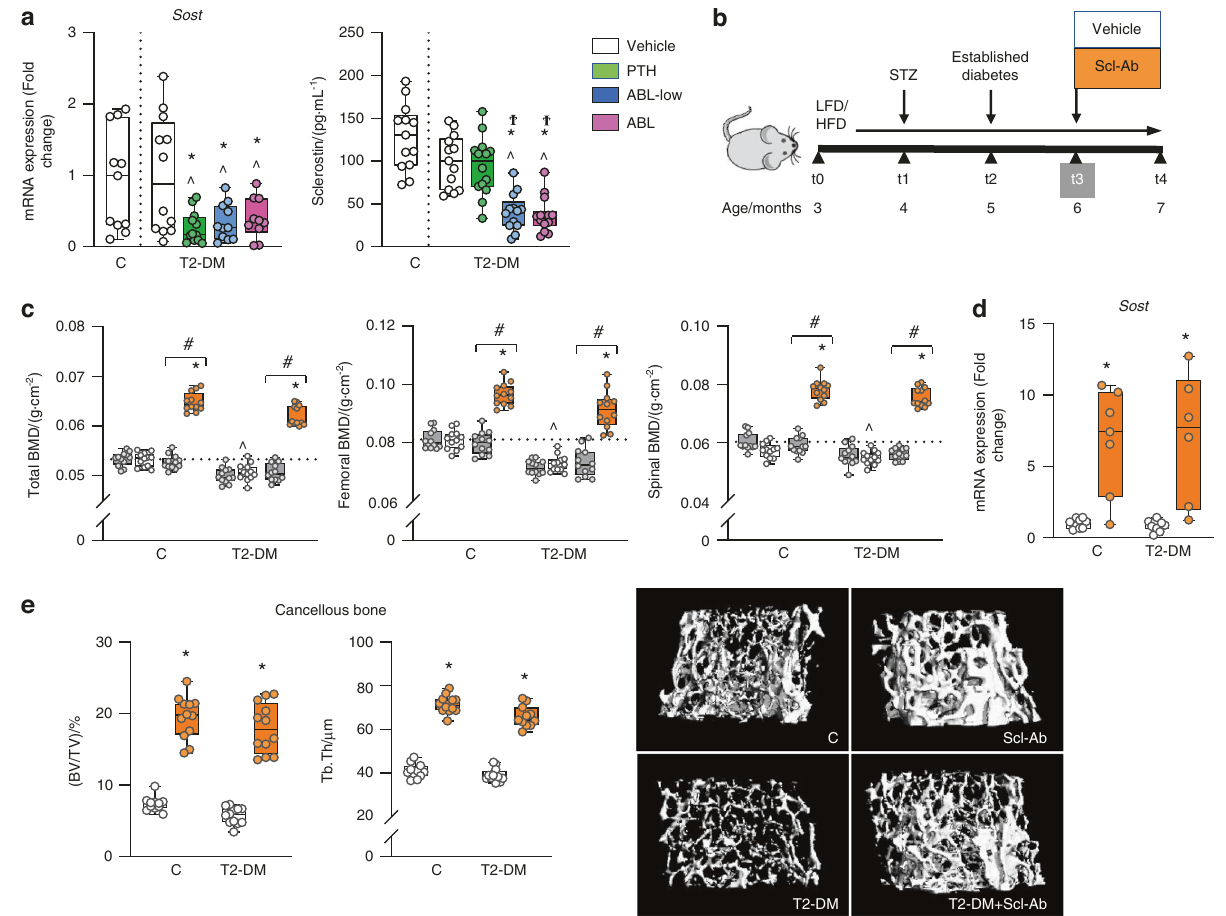
Fig. 5 PTH and ABL decreased Sost expression in T2-DM bone, and the anti-sclerostin antibody restored and further increased BMD and cancellous bone in T2-DM. a Expression of the osteocytic marker Sost in bone and Sclerostin levels in serum of DM mice after treatment with PTH or ABL (at t4). b Study design: Male C57BL/6 DM mice as well as C mice were administered with vehicle or Scl-Ab once a week for 4 weeks. c Total, femoral and spinal BMD before treatment (at t3, grey bars) and after treatment (at t4) with vehicle (white bars) or Scl-Ab (orange bars). d Expression of Sost in bones of C and DM mice after (at t4) treatment with vehicle or Scl-Ab. e Micro-CT analysis of femur cancellous bone: BV/ TV and trabecular thickness (Tb.Th), after treatment with vehicle or Scl-Ab and representative micro-CT images. n = 10-12 mice/group. Data are presented as box & whisker plots where each dot represents a mouse. ^ P < 0.05 versus C mice by one-way ANOVA for ( a ) or two-w a y ANOVA with post hoc Dunnet ’ s correction for ( c ). For ( a ), * P < 0.05 versus T2-DM mice treated with vehicle and Ϯ P < 0.05 versus T2-DM mice treated with PTH by one-way ANOVA with post hoc Tukey ’ s correction. For ( c – e ), * P < 0.05 versus respe c tive vehicle-treated mice by two-way ANOVA with post hoc Bonferroni ’ s correction. # P < 0.05 versus respective mice at t3 (grey bars) by one-way ANOVA with post hoc Tukey ’